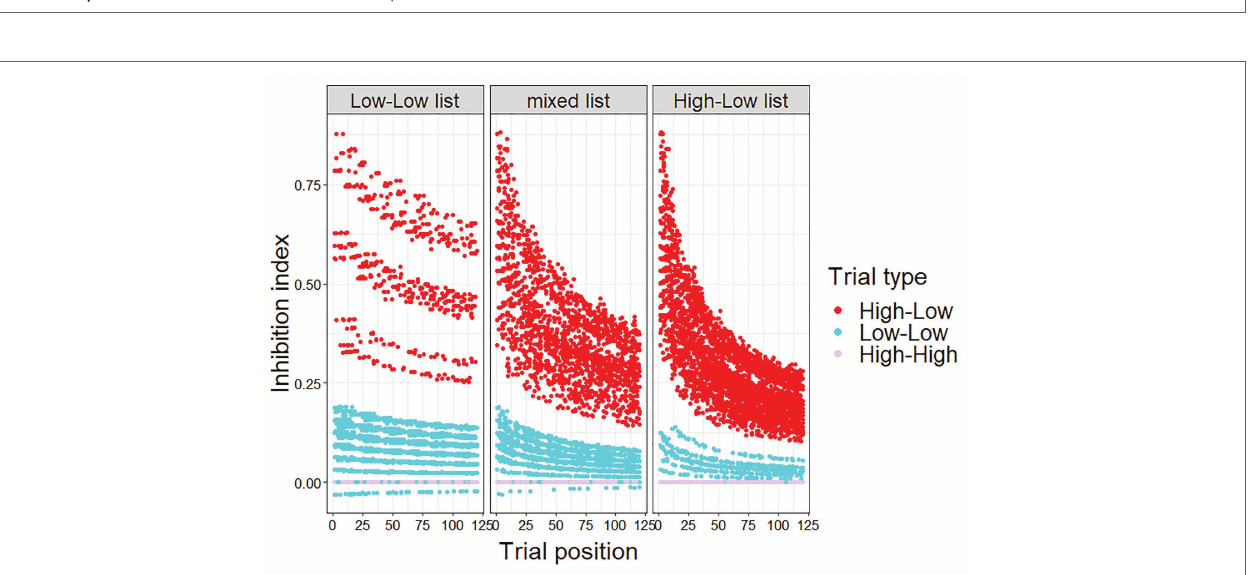
FIGURE 4 | Calculated inhibition index ( μ *PE) in Experiment